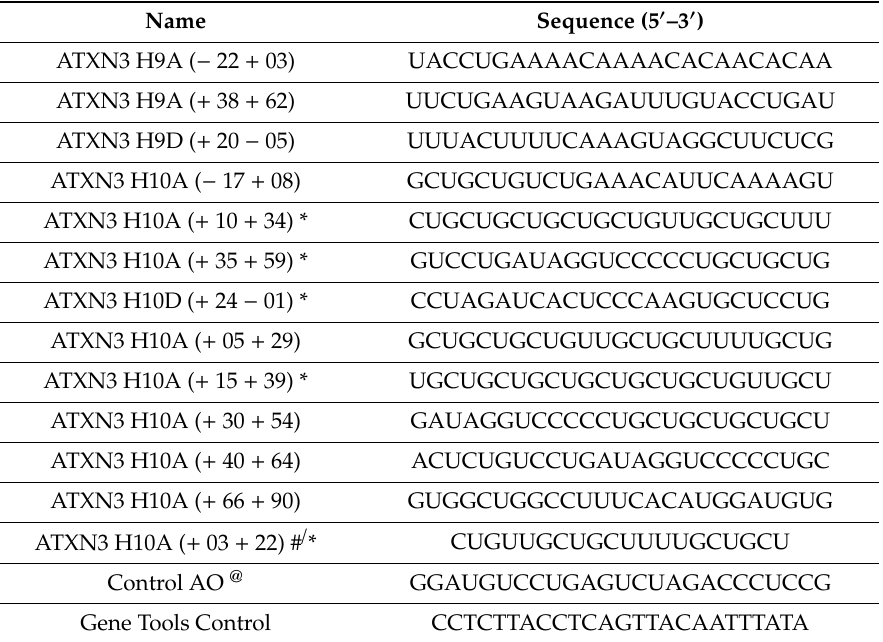
Table 1. Sequences and coordinates of AOs employed in this study.